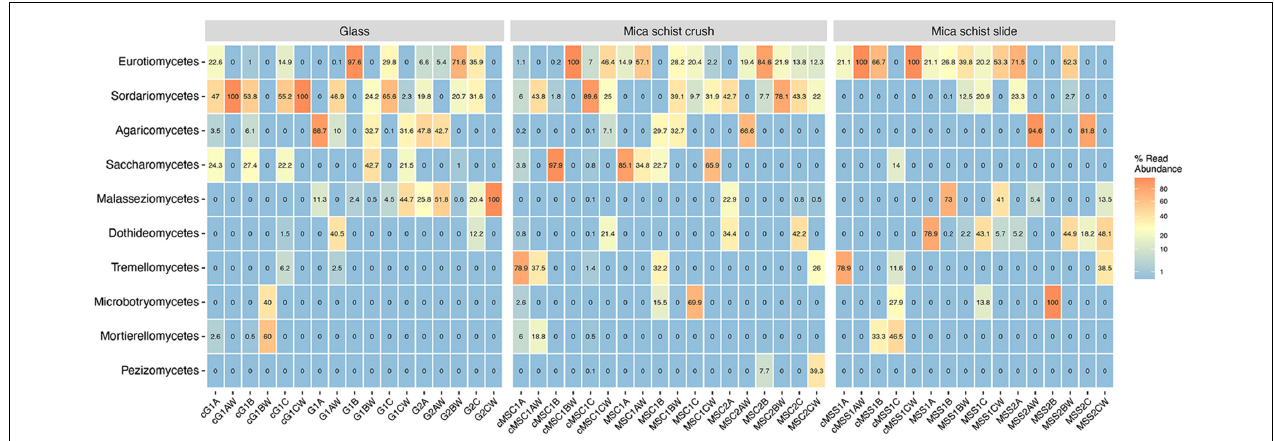
FIGURE 5 | Relative abundance of top ten fungal classes as percentages of reads across sample types. Sample name codes are listed in Table 1 .